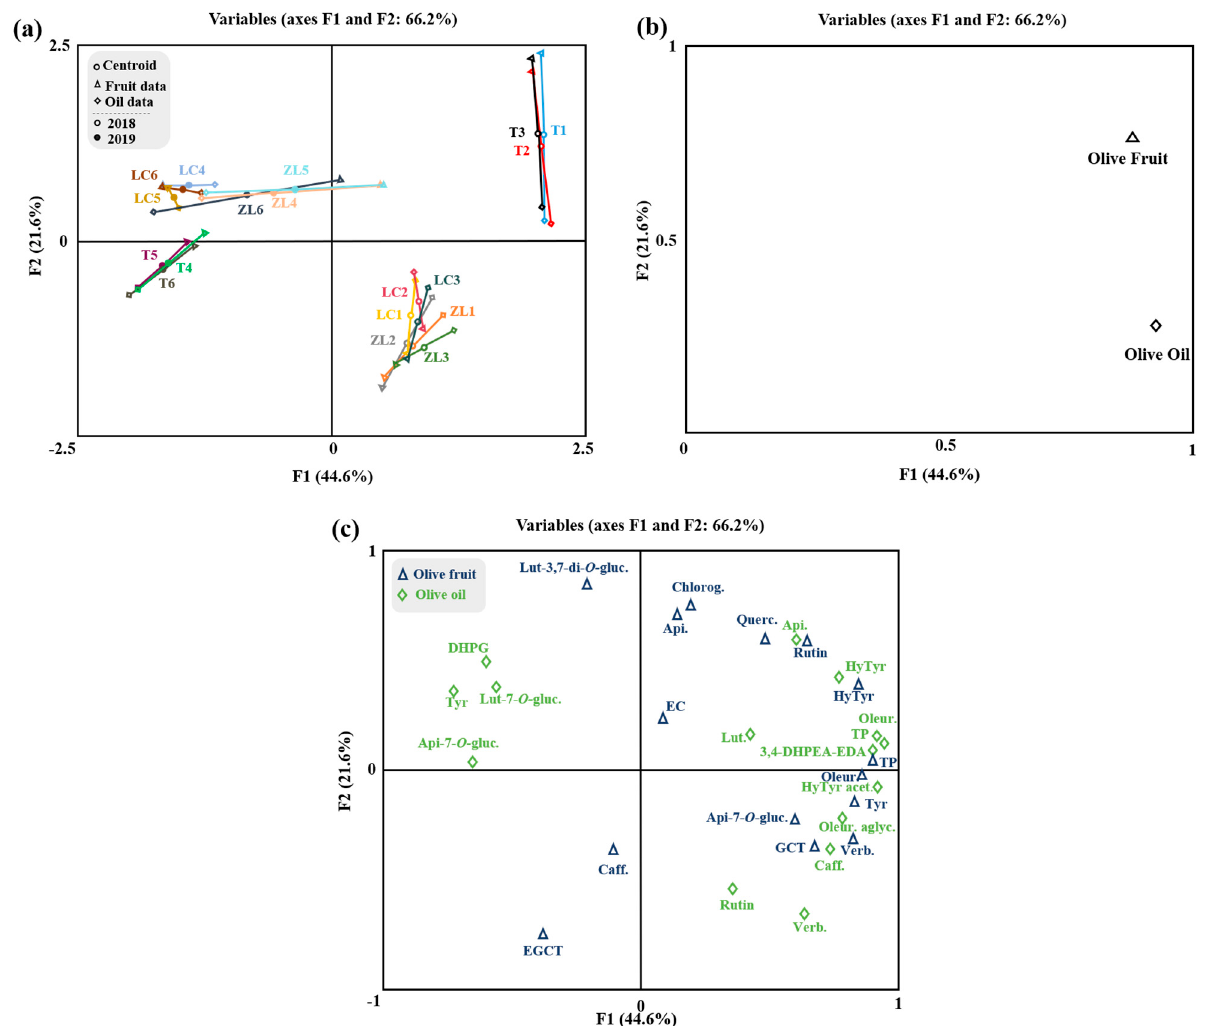
Figure 3. Multiple factorial analysis of phenolic compounds of olive fruit and olive oil. ( a ) Representation of olive samples and clouds; ( b ) representation of groups (tables) of variables; and ( c ) distribution of variables. Centroid ( ○ ); olive fruit data ( ∆ ); olive oil data ( ◊ ); centroids respective to samples from 2018 ( ○ ) and 2019 ( ● ). Apigenin-7- O -glucoside (Api-7- O -gluc.), caffeic acid (Caff), lu- teolin-7- O -glucuside (Lut-7- O -gluc.), luteolin-3,7-di- O -glucoside (Lut-3,7-di- O -gluc), rutin, verbas- coside (Verb.), 3,4-dihydroxyphenylglycol (DHPG), oleuropein aglycone (Oleur. aglyc.), tyrosol (Tyr), dialdehydic forms of decarboxymethyl elenolic acid linked to hydroxytyrosol (3,4-DHPEA- EDA), hydroxytyrosol (HyTyr), apigenin (Api.), total phenols (TP), oleuropein (Oleur.), luteolin (Lut.), hydroxytyrosol acetate (HyTyr acet.), epigallocatechin (ECGT), epicatechin (EC), gallocate- chin (GCT), chlorogenic acid (Chlorog.), quercetin-3,7-di- O -glucoside (Querc.).